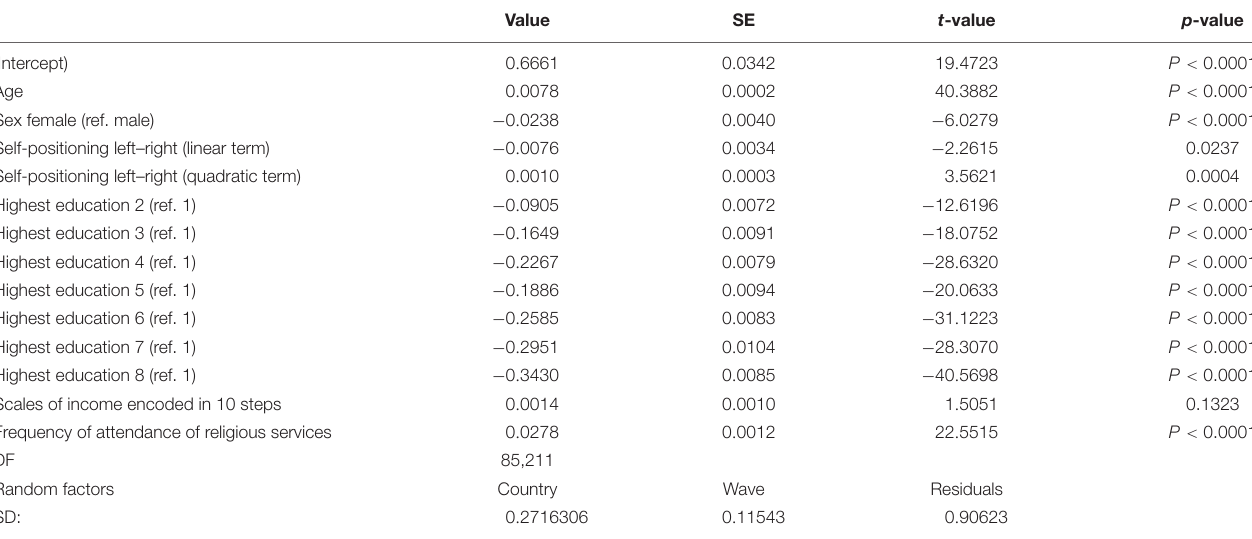
FIGURE 1 | WVS data set: (A) political orientation and mean ( ± SE) number of children and (B) quadratic model of political orientation and mean number of children. TABLE 1 | WVS: linear mixed model of number of children on basis a Poisson error structure regressing on political orientation included as quadratic term, age, sex, education (lowest education level 1 as reference), scales of income and frequency of attendance of religious services, with wave, and country as random